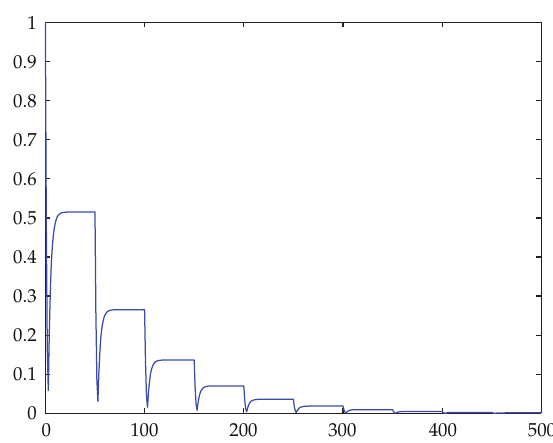
Figure 3: The Gauss collocation method with m (cid:4) 3 and p (cid:4) 50 for (cid:2) 7.1 (cid:3) .